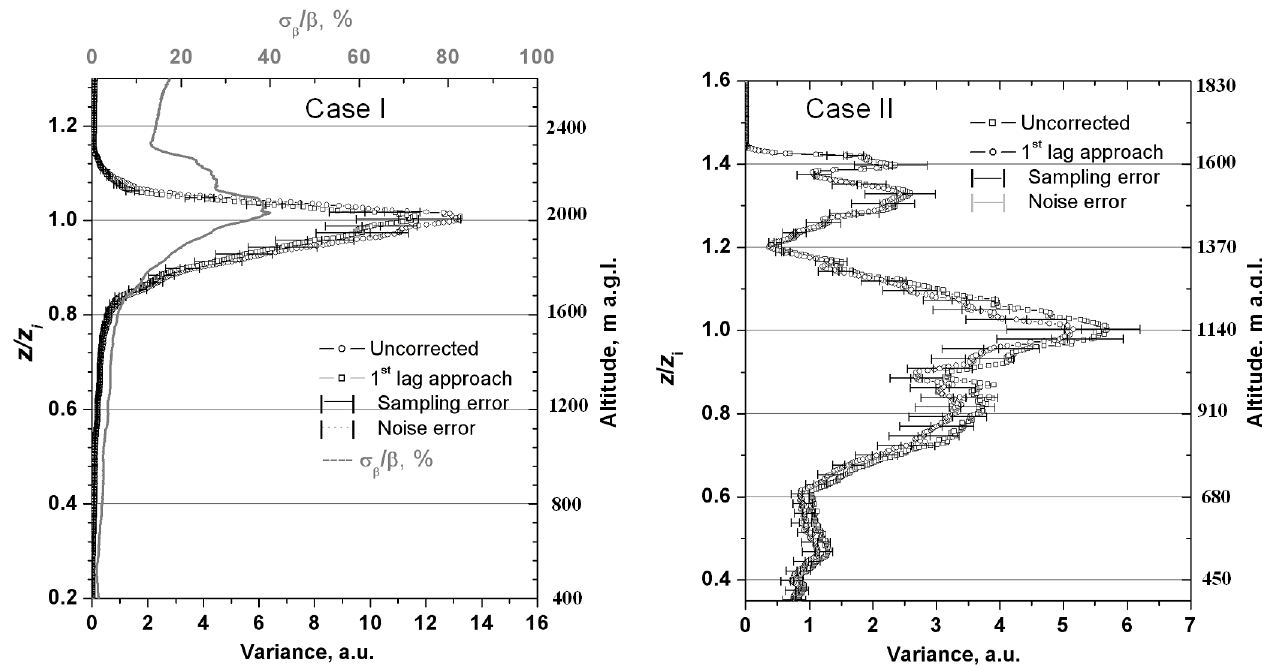
Fig. 12. Vertical distributions of the variance for Case I (left) and Case II (right) with noise correction (1st lag approach) and without any correction. The vertical coordinates are scaled as in Fig. 11. Statistical and sampling errors are plotted with the corrected profiles. A profile of σ β / β is shown for comparison (solid gray